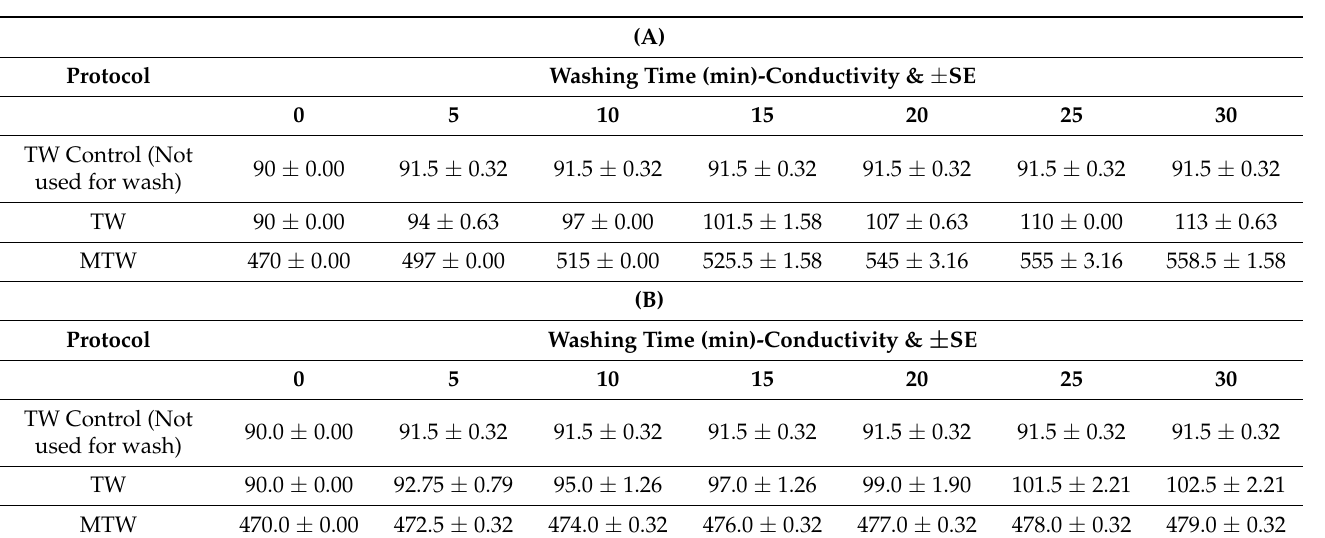
Table 1. ( A ). Chloropyrifos ® Removal by Washing: First Washing Conductivity ( µ S cm − 1 ). ( B ). Chloropyrifos ® Removal by Washing: Second Washing Conductivity ( µ S cm − 1 ). (A)